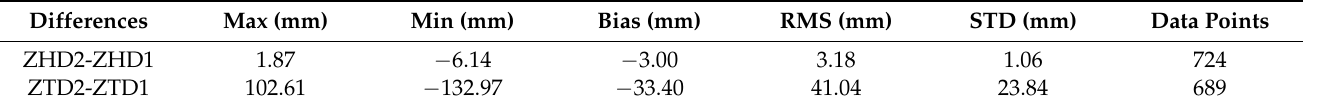
Table 7. Statistical summary for Figure 7a,b for the comparison between ZHD1 and ZHD2 (ZHD2 minus ZHD1) and between ZTD1 and ZTD2 (ZTD2 minus ZTD1) in terms of max, min, bias, STD, and